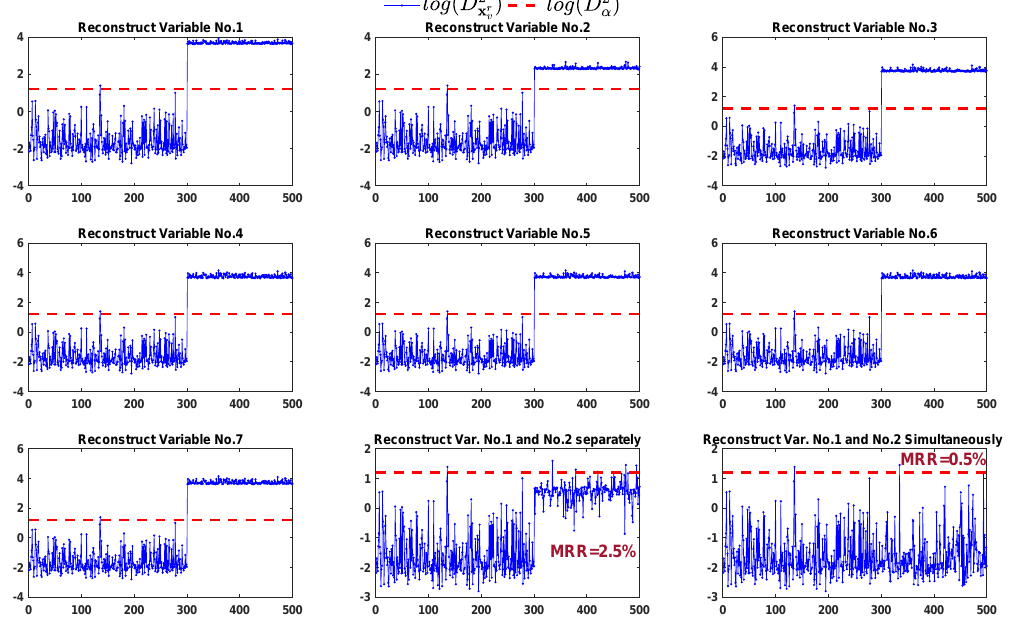
Figure 3. The fault detection results by eliminating faulty variables for case